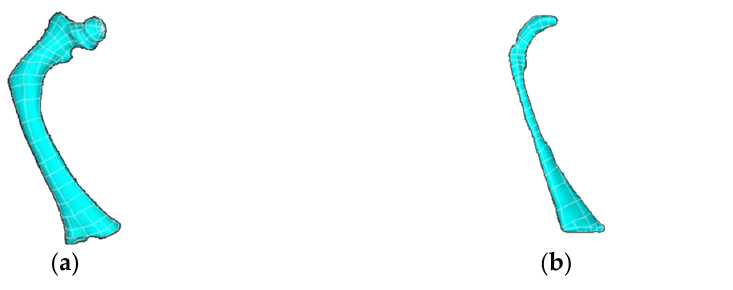
Figure 1. Models of cortical and trabecular tissue of the femur of an infant with type III OI: ( a ) cortical tissue; ( b ) trabecular tissue.